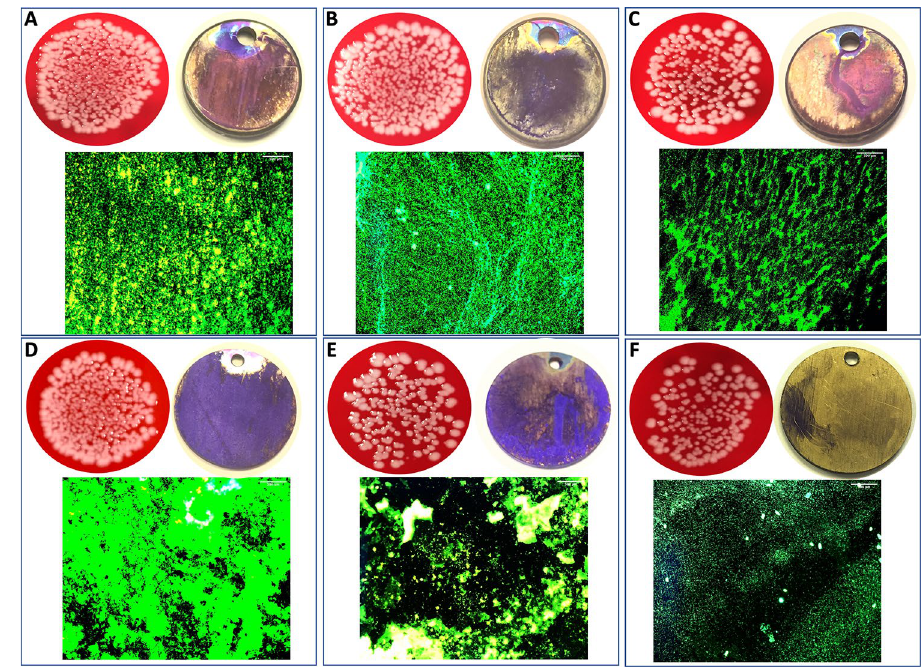
Figure 2. Bacterial cell adhesion and biofilm formation: Bacterial cell count (upper left) was evaluated by culturing S. epidermidis on the modified discs. After incubation, discs were sonicated and the supernatant was transferred on agar plates and cultured overnight. CFU/mL were evaluated by counting cells with image processing software. Biofilm formation on titanium discs after incubation with S. epidermidis and crystal violet staining (upper right). Biofilm was measured by analyzing the covered area with image processing software. Bacterial cell adhesion was measured after fluorescence staining with SYTO 9 (bottom image) by calculating the covered area. Selenium-silver modified discs exhibited distinct reduction in bacterial cell adhesion and biofilm formation. ( A ) unmodified control; ( B ) phosphate-doped titantium nanotubes (pTNT); ( C ) selenium- incorporated phosphate-doped TiO 2 -nanotubes (SepTNT); ( D ) hydroxyapatite coated (HA) phosphate-doped